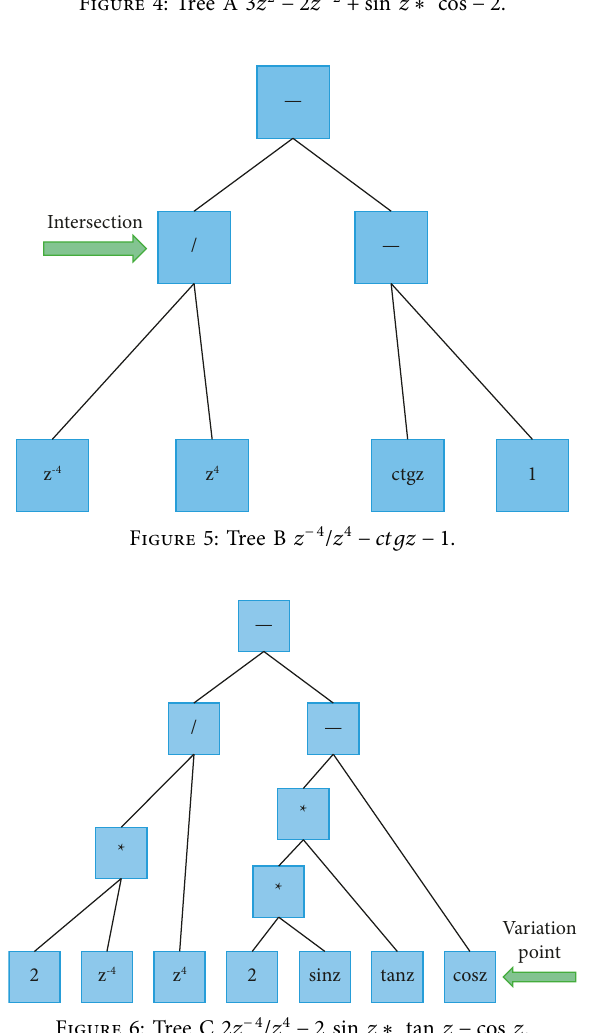
Figure 7: Tree D 3 z 2 − 2 z − 2 − ctgz − 1.